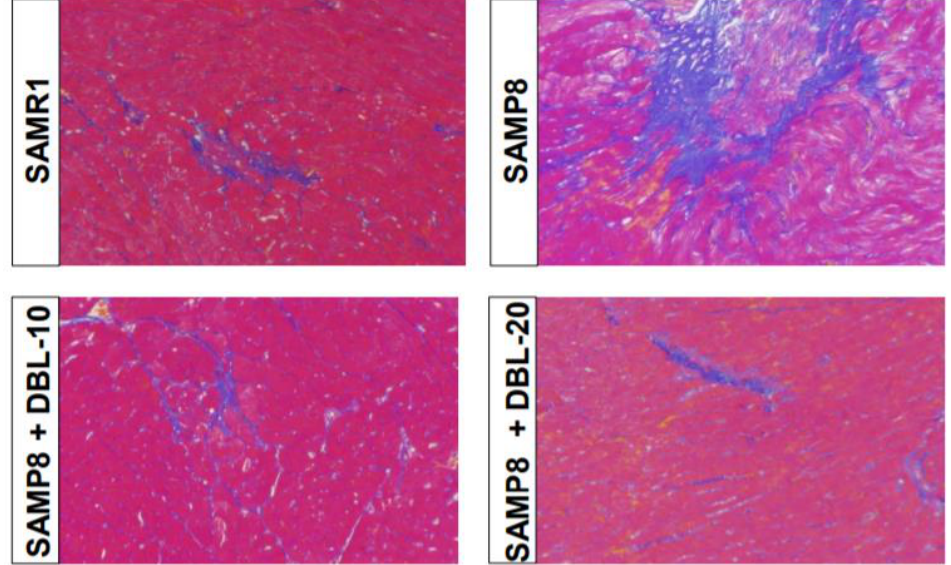
Figure 2. The regression of the aging-induced fibrosis after treatment with DBL. The images of Azan- Mallory (A-M) stained heart sections of SAMR1 and SAMP8 mice depict cardiac fibrosis (blue